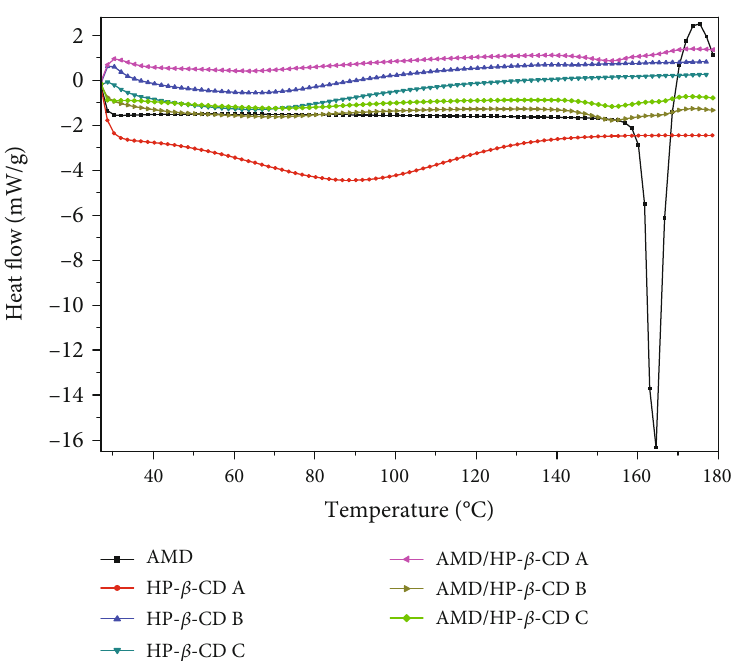
Figure 12: The DSC curves of the three AMD/HP- β -CD inclusion complexes and their components. Table 4: DSC data for inclusion complexes and their components. Code